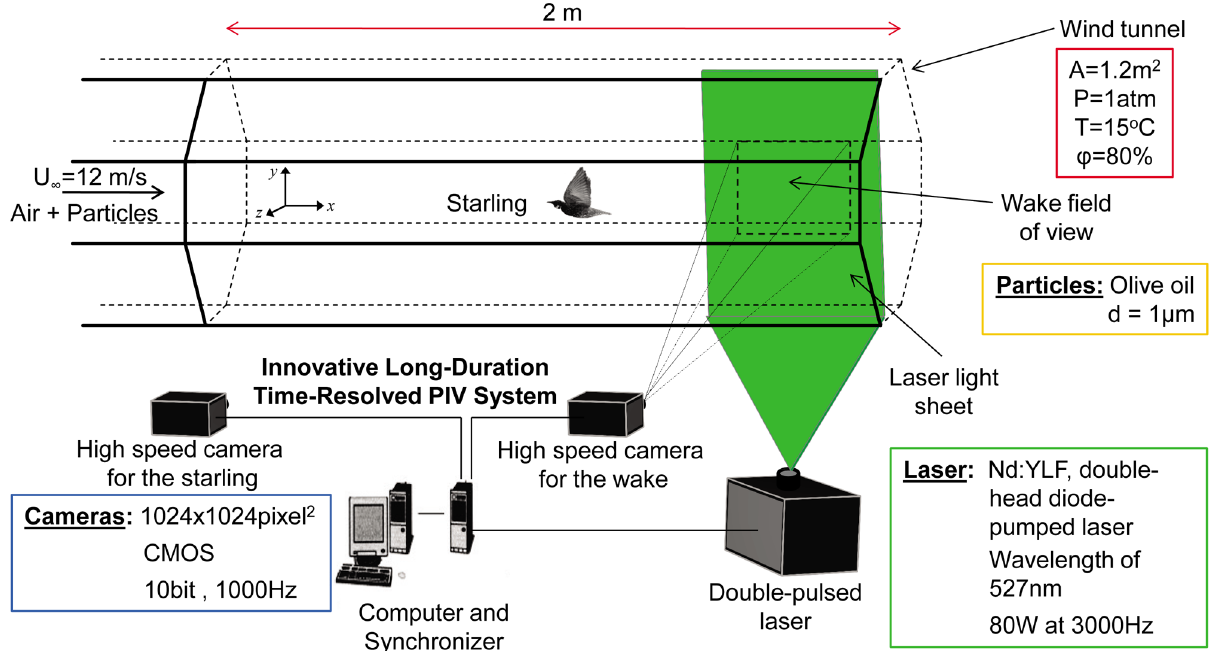
Figure 1. Illustrative scheme of the avian wind tunnel and the experimental setup system.